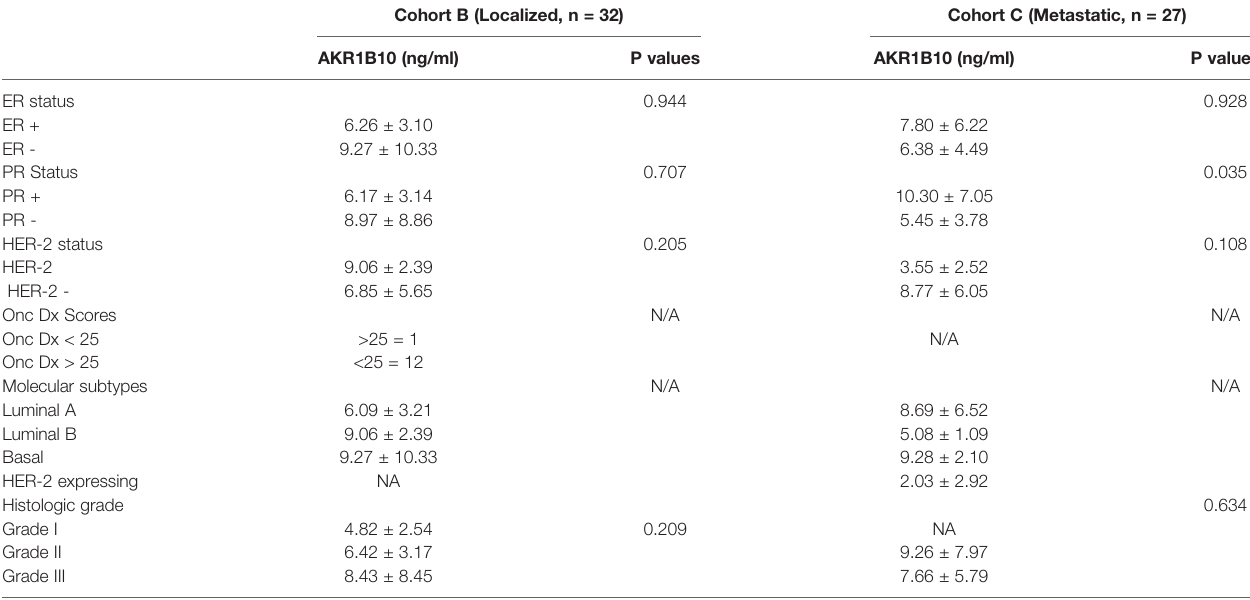
TABLE 2 | Correlation between AKR1B10 levels and hormonal receptor status, oncotype DX scores, and molecular